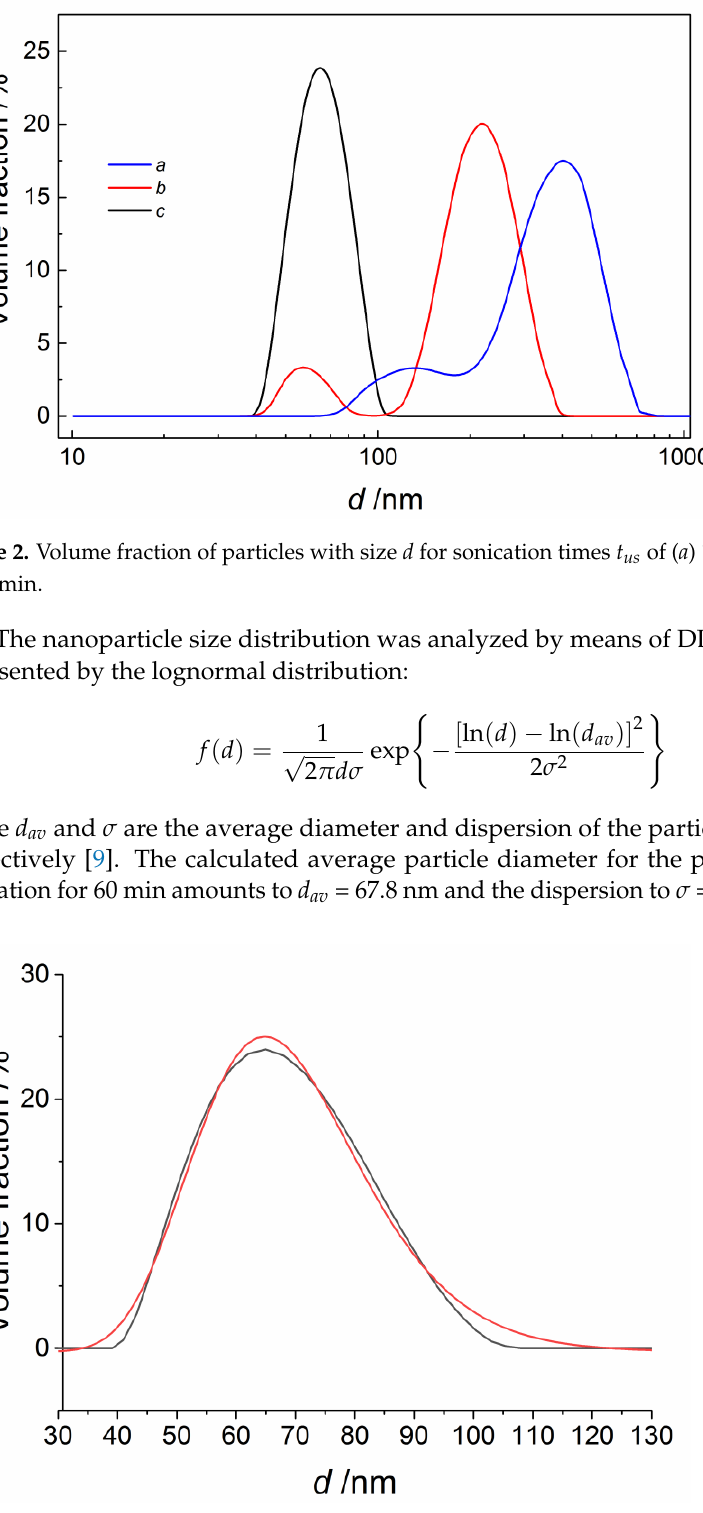
Figure 3. Size distribution of the volume fraction of an ensemble of SFMO nanoparticles after ultrasonic dispersion for 60 min determined by DLS analysis (black line) and its approximation by the log-normalized function ƒ ( d ) (red line).